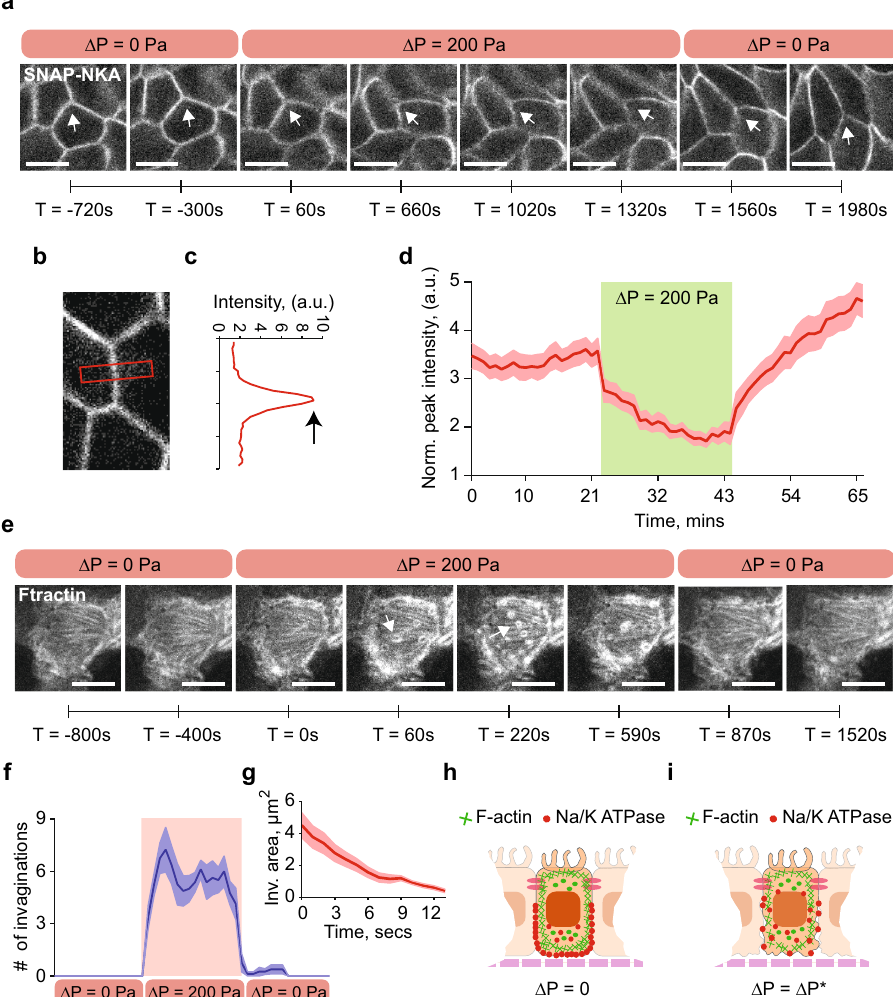
Fig. 3 Δ P decreases baso-lateral Na + /K + ATPase localization by disrupting F-actin cortex. a Live cell imaging MDCK-II cells stably expressing SNAP- tagged Na + /K + ATPase (NKA) a-subunit and stained with TMR-STAR dye in the MFKP. Time-lapsed confocal images of cells ’ lateral side in three consecutive conditions: zero pressure ( Δ P = 0), pressure gradient ( Δ P = 200 Pa) and pressure released ( Δ P = 0). The arrowhead indicates disruption of lateral NKA expression in regions of interest (ROIs) at various time stamps. Scale bar = 10 mm. b A zoomed confocal slice of an ROI in MDCK-II cells expressing SNAP-tagged NKA and stained with TMR-STAR dye. c NKA intensity is quanti fi ed in a red band centered between two cells in b . The intensity pro fi le in c is the vertical average intensity along the red box in b , the peak (indicated by black arrow) is the maximum intensity of NKA. d Mean of normalized peak lateral NKA intensity for the same cell over the course of three pressure conditions in a . Shading represents the SEM. ( n = 25, N = 3, cells, biological replicates). e Live cell imaging of transiently transfected MDCK-II cells expressing GFP-tagged F-actin (Ftractin). Time-lapsed confocal images of the baso-lateral side of the cells were taken under three consecutive conditions: Δ P = 0, Δ P = 200 Pa, and pressure released ( Δ P = 0). Scale bar = 10 mm. Pressure application induces rapid high-frequency invaginations in the baso-lateral domain. White arrowhead indicates F-actin rings, which are cross- section of invaginations. f Number of invaginations per unit cell over the course of three pressure conditions in e ( n = 8, N = 3, cells, biological replicates). g Mean area of invaginations as a function of time under pressure. Shading represents the SEM. ( n = 10, N = 3, cells, biological replicates). The invaginations have an average lifetime of ~15 s and disappear when pressure is released as shown in f . h Schematic showing co-localization of F-actin (green lines) and NKA (red dots) in cells in MFKP at Δ P = 0. i Hydrostatic pressure gradient results in high-frequency invaginations on the baso-lateral F-actin cortex and a reduction in NKA localization in the lateral